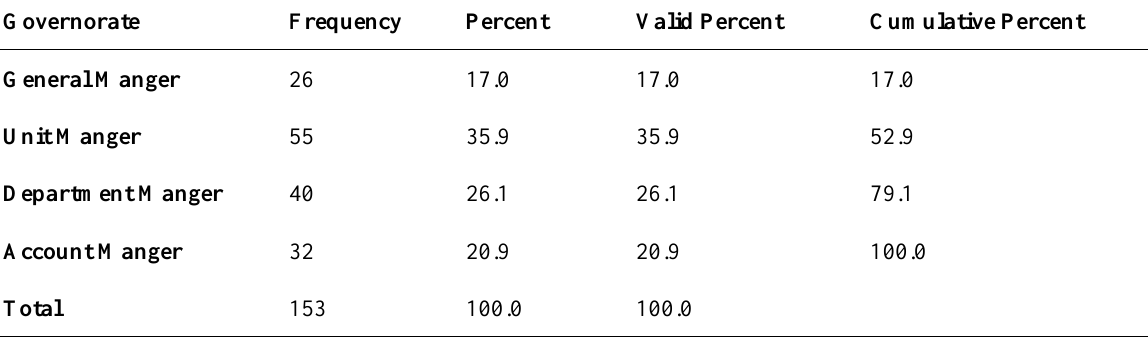
Table 2. Frequency and percentages of the respondents